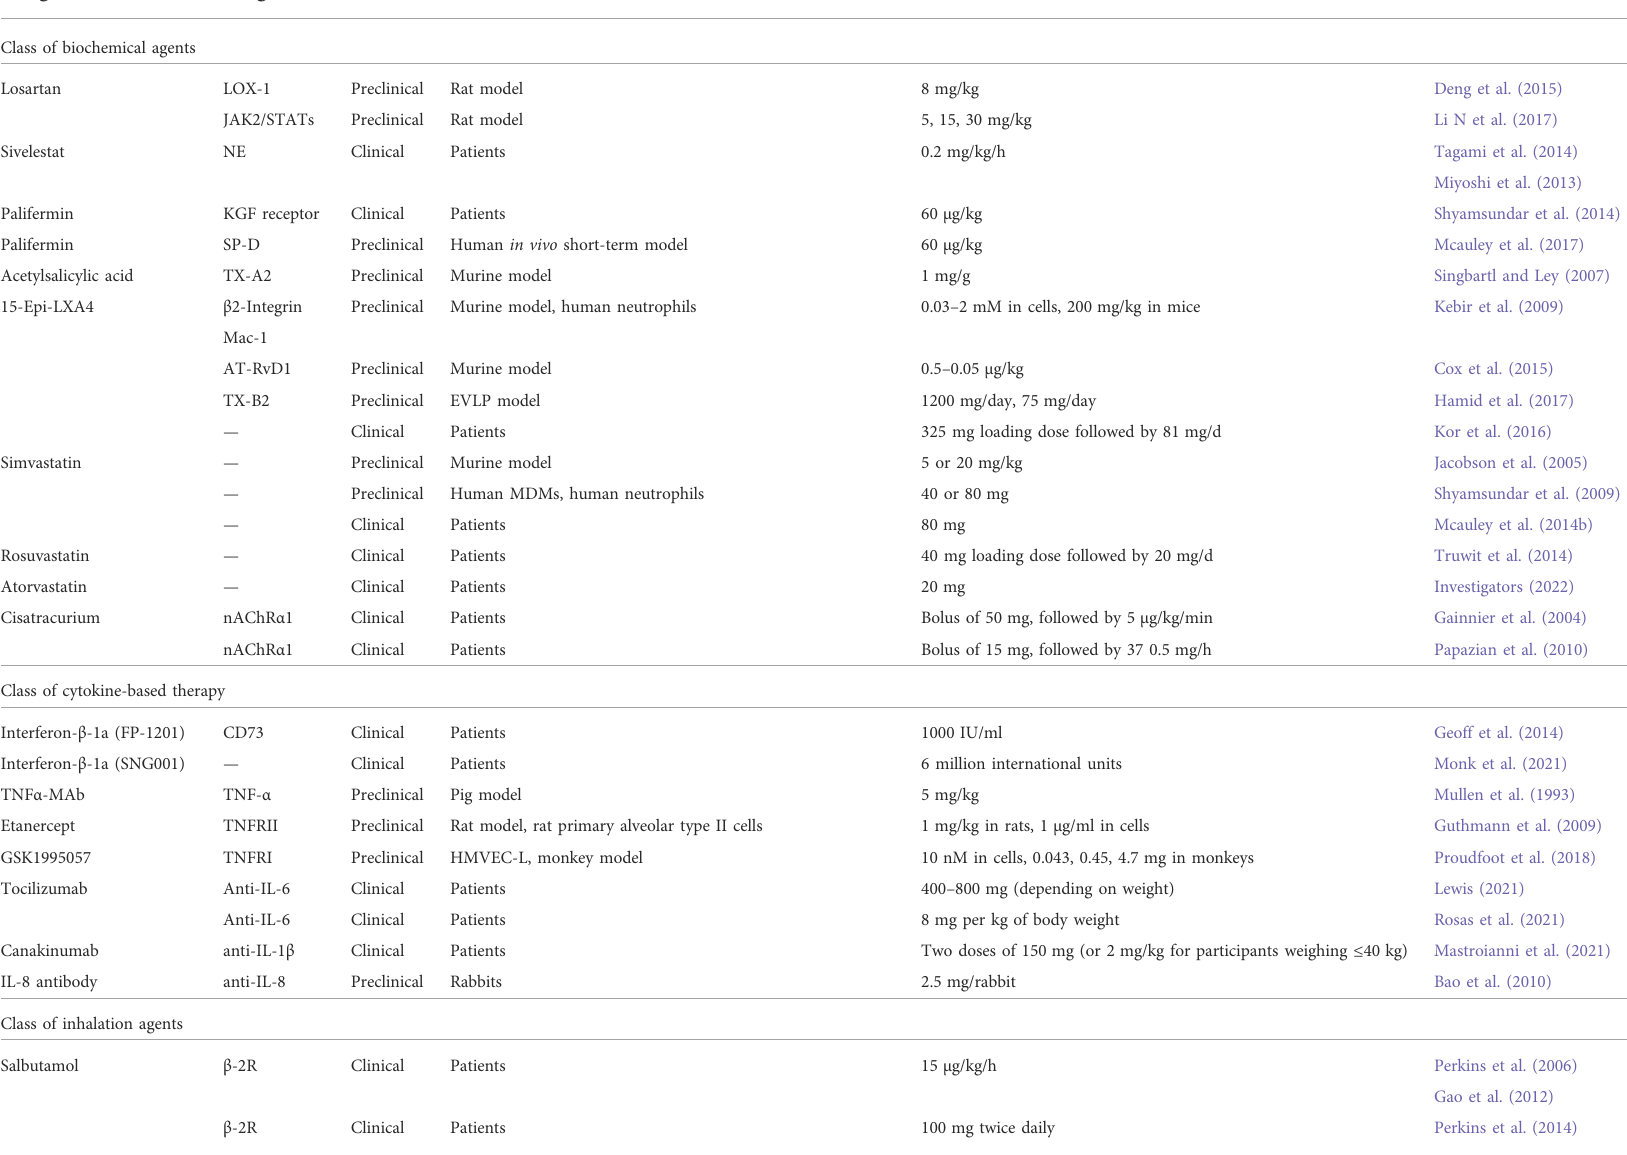
TABLE 1 Traditional medicines for the treatment of